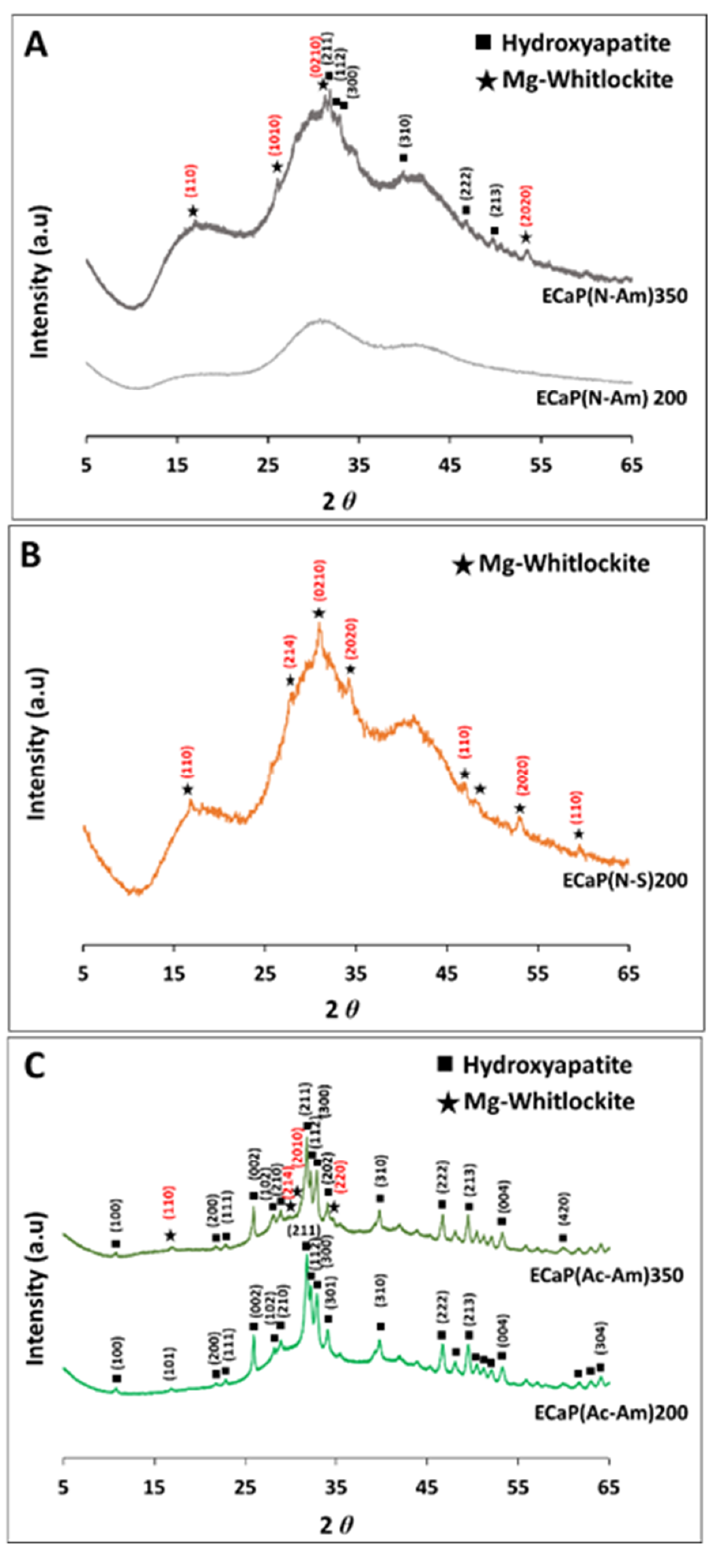
Figure 4. The XRD spectra of samples synthesised at 200 °C and 350 °C via a hydrothermal synthesis process at a pH of 11 of eggshell solution and a pH of 6 of struvite solution adjusted using ( A , C ) NH 4 OH (Am) and ( B ) NaOH (S) individually, where eggshells and struvite were dissolved in ( A , B ) HNO 3 (N) and (C) CH 3 COOH (Ac).